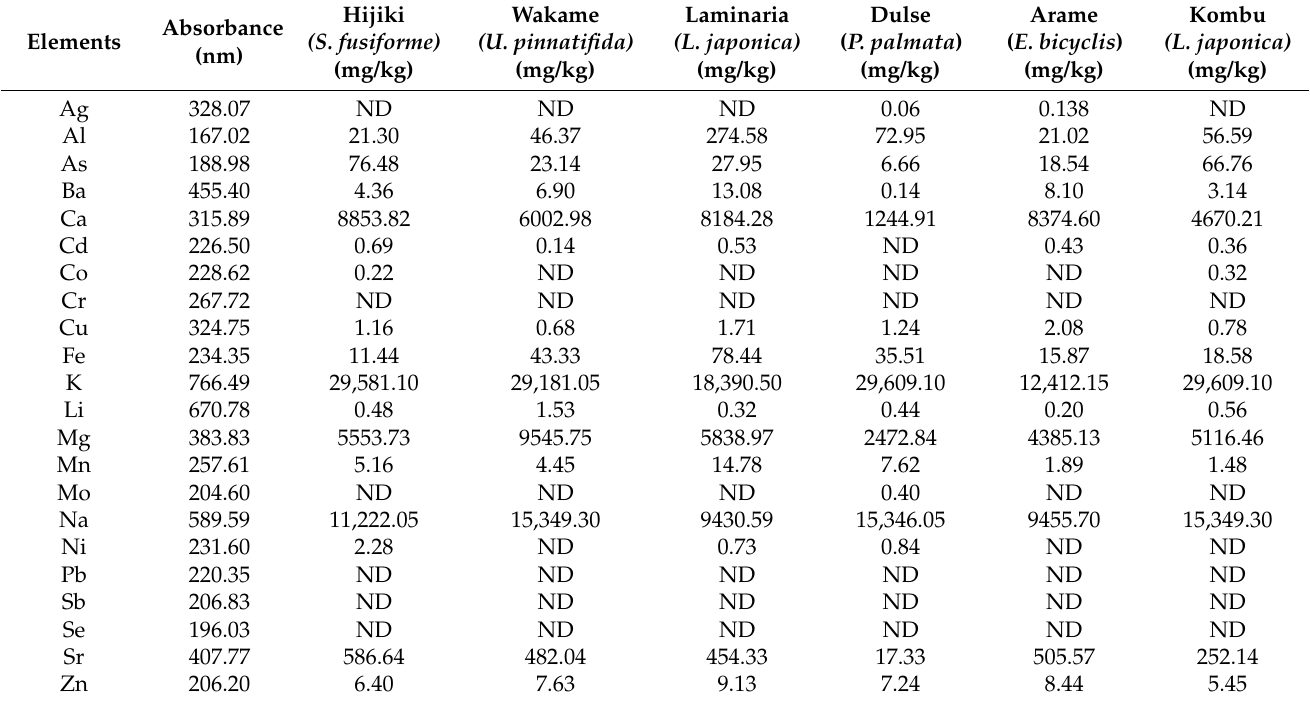
Table 2. Chemical elements and heavy metals of